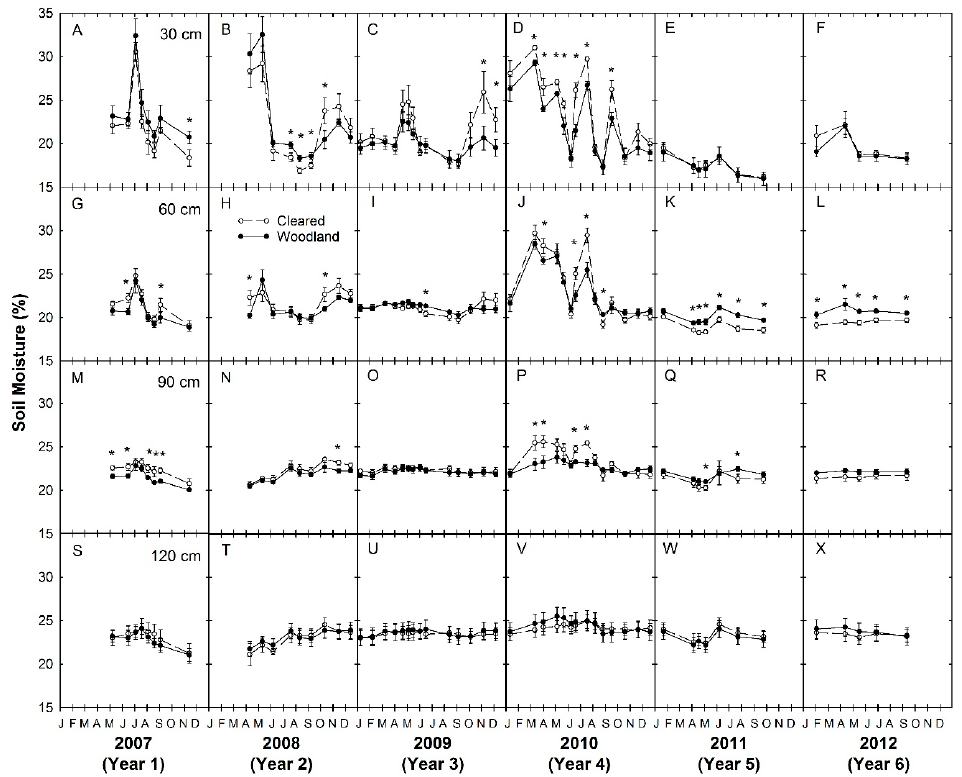
Figure 3. Soil moisture at 4 depths in cleared and woodland treatments, 2007 – 2012. Letters on x-axis indicate the beginning of each month and gap between hash marks is the duration of that month. Vertical bars are ±1 standard error (n = 4). Means with an asterisk above are significantly different at p ≤ 0.05. Capital letters A through X are used to identify each panel by year and soil depth.